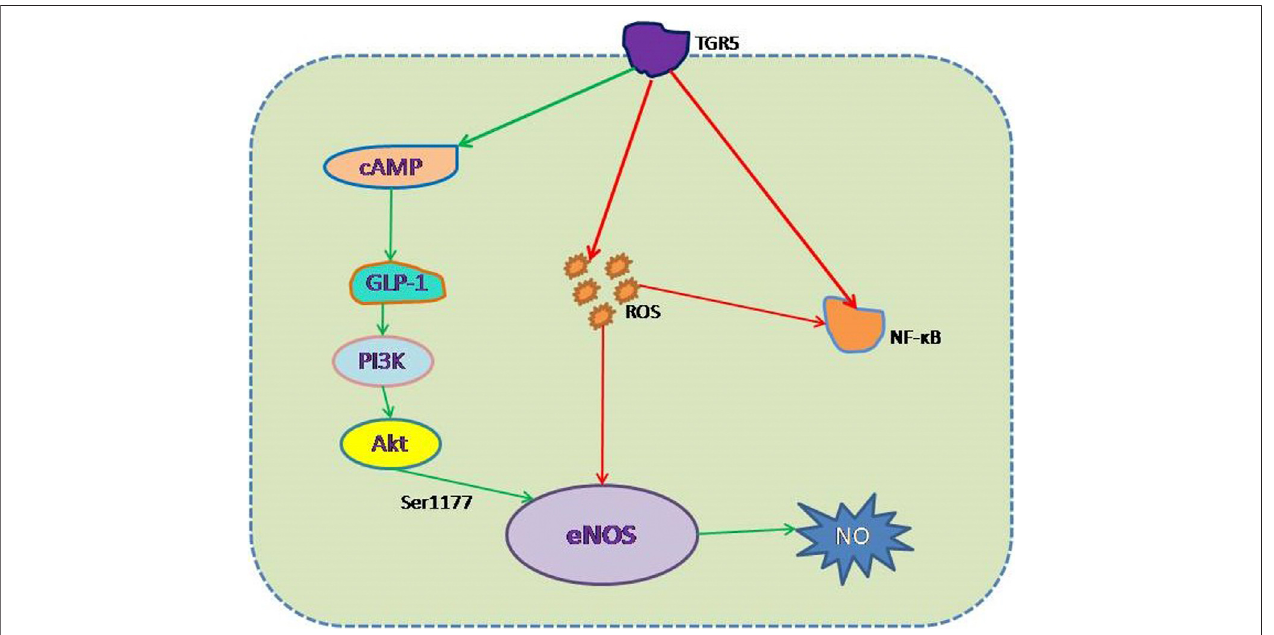
FIGURE2| MechanismwherebyTGR5protectsagainsthigh-glucose-inducedendothelialdamage.(1)Negativeeffect(redline):inhibitionofthegenerationofROS and the activation of NF- κ B, thereby reducing eNOS decoupling and NF- κ B – mediated ED. (2) Positive effect (green line): increase in eNOS expression via the TGR5- GLP-1-PI3K-eNOS pathway, which mimics GLP-1